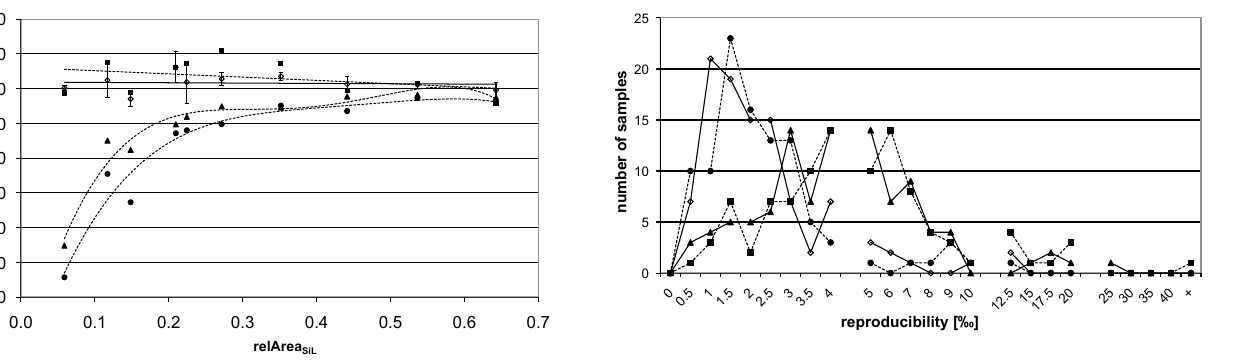
Fig. 6. Resulting non-linearity for different background detection algorithms. The trend lines (linear for SPI and Individual BGD, polynomial order 4 for TimeBased BGD and Median BGD) illus- trate the basic tendencies. Error bars are only included for SPI.